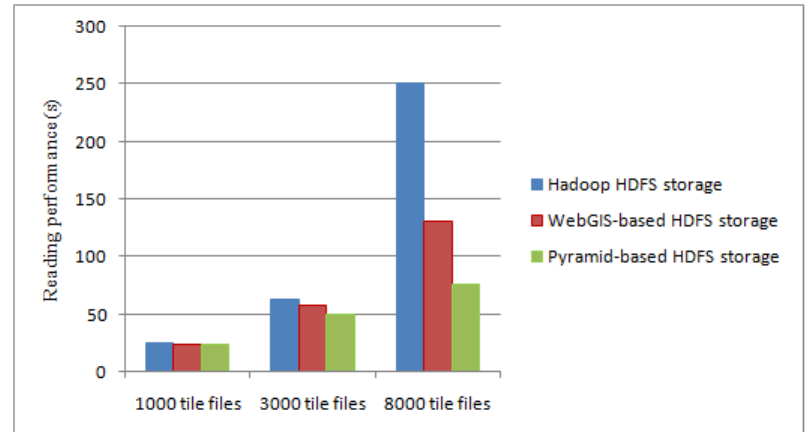
Figure 10. Reading time comparison of different tile data